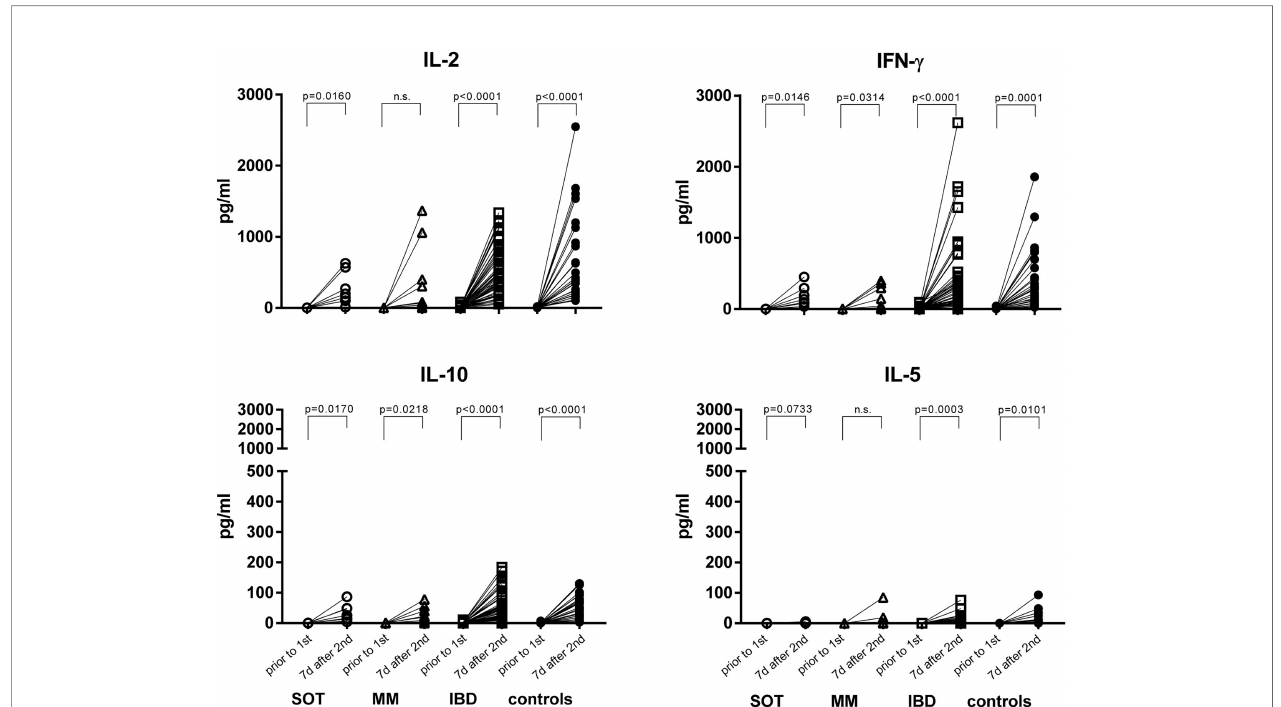
FIGURE 2 | S1-spike-induced cytokine production before vaccination and one week after the second mRNA vaccine dose. PBMCs were stimulated with the peptide pool of the S1 subunit of the SARS-CoV-2 spike protein for 24 hours. Afterwards, the supernatants were collected and IL-2, IFN- g , IL-10 and IL-5 were measured by the Luminex system. SOT (n=8) are represented as open circles, MM (n=9) as open triangles, IBD (n=52) as open squares and controls (n=26) as full circles. Differences between the groups below p values of 0.05 were regarded as signi fi cant. n.s., non signi fi cant.